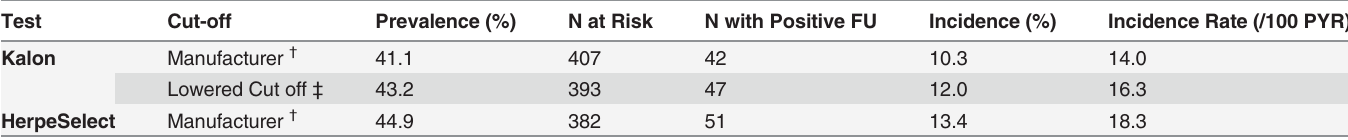
Table 2. Estimated HSV-2 incidences for both assays using the manufacturer ’ s instructions and the lowered cut-off of 0.66 for the Kalon assay. Test Cut-off